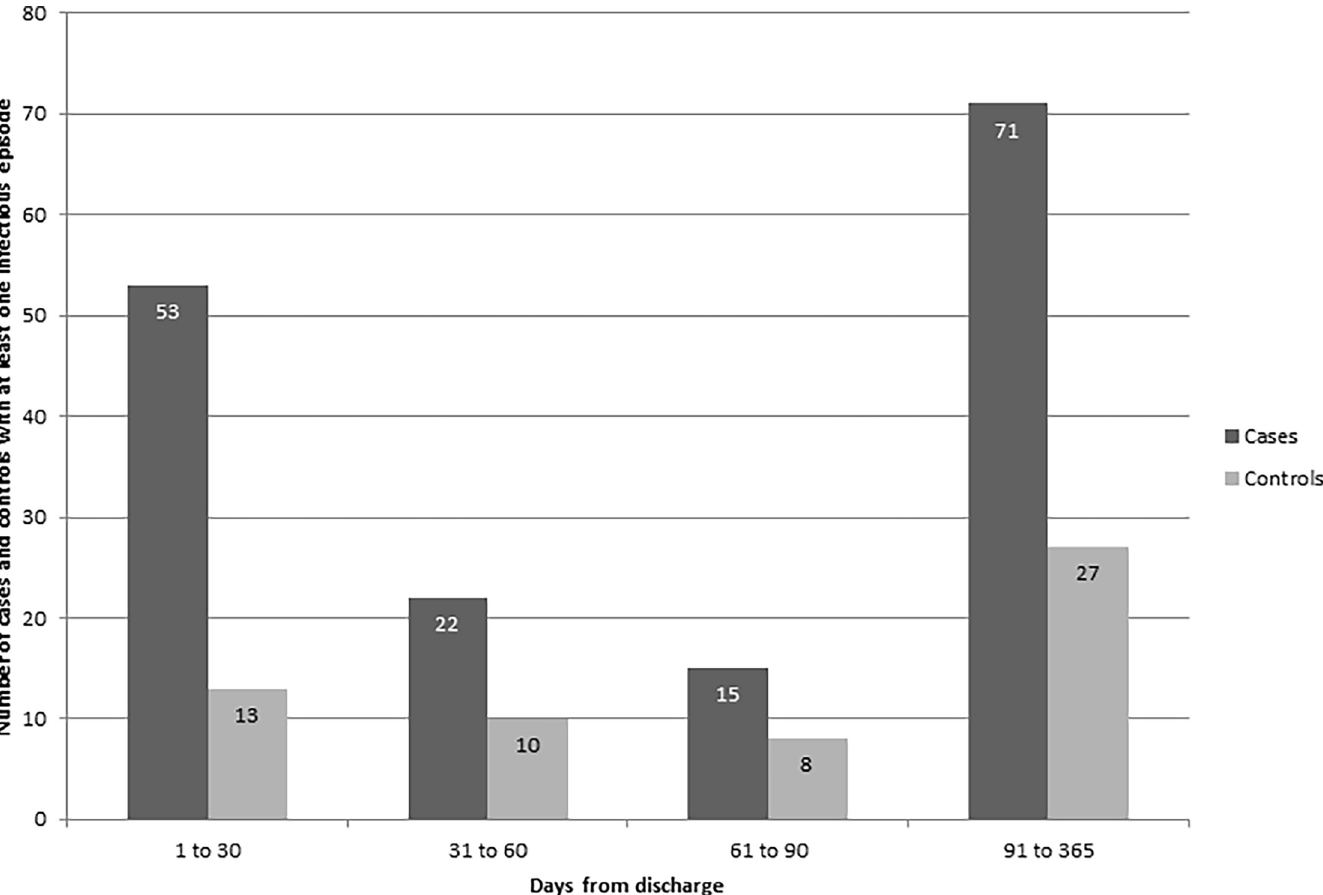
Fig 2. Number of cases and controls with at least one infectious episode at 1 to 30 days, 31 to 60 days, 61 to 90 days, and 91 to 365 days following discharge from the index hospitalization.